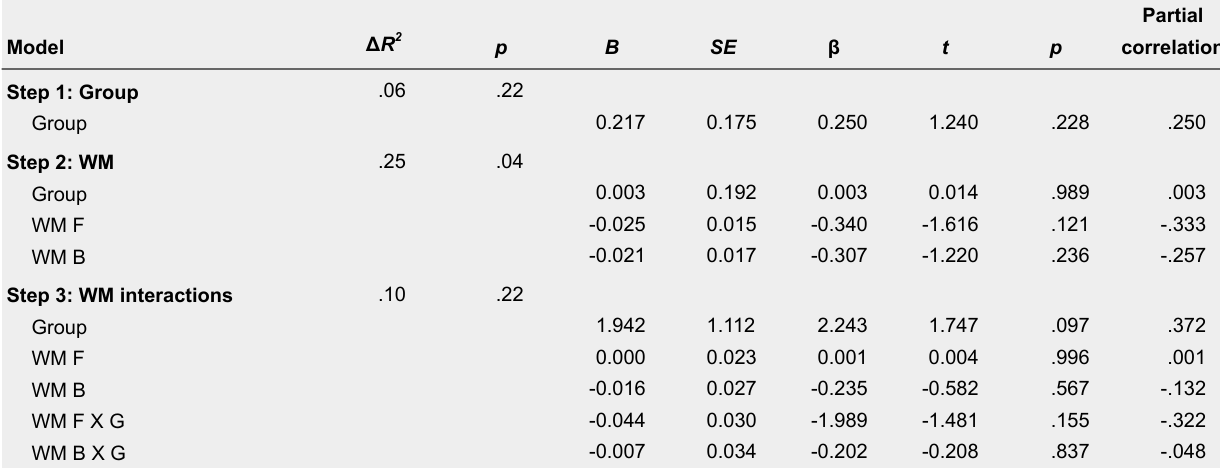
Hierarchical Regression